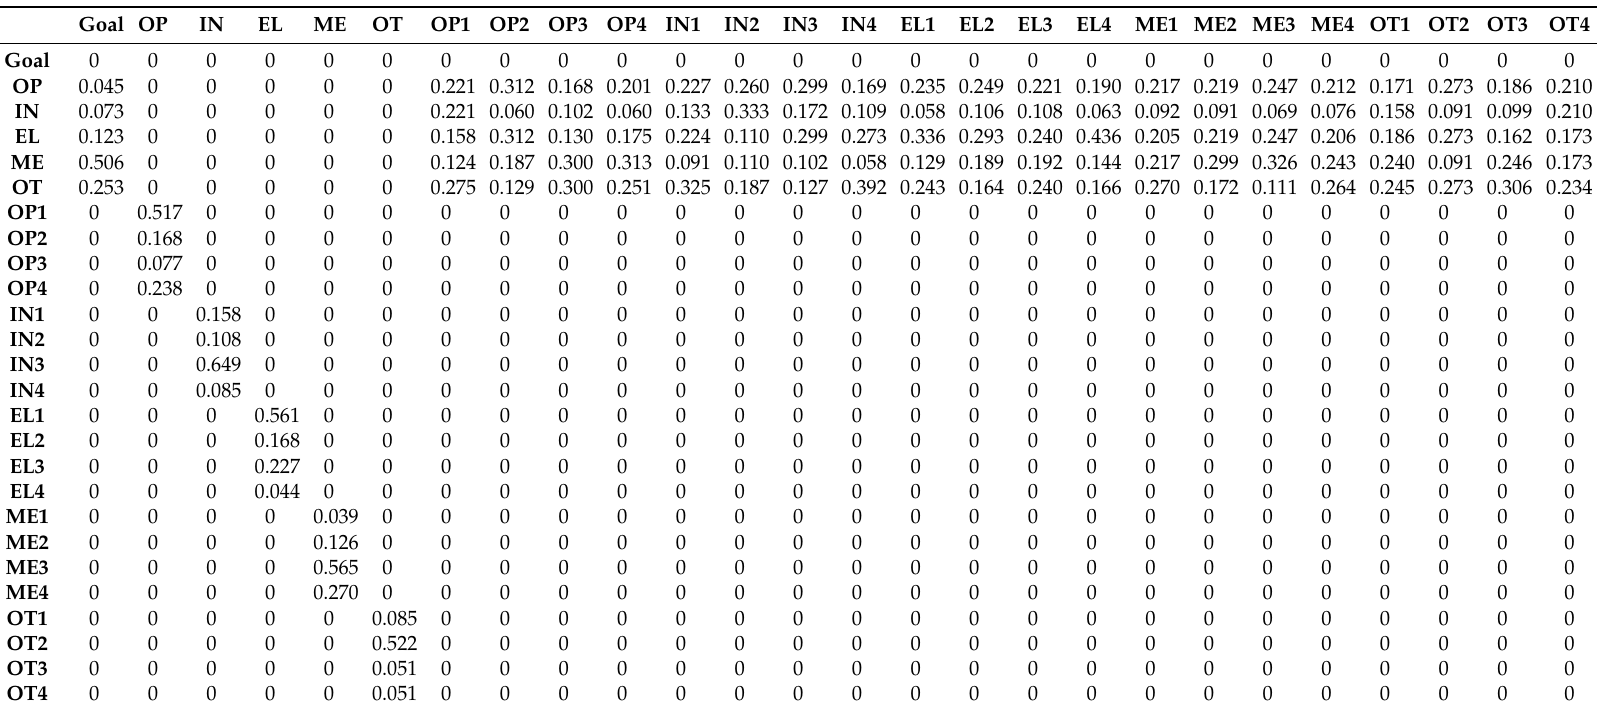
Table 11. Supermatrix of Clusters and